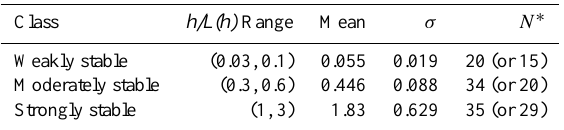
Table 1. Description of the classification of stability based on the parameter h/L(h) at tree top, where h is the tree canopy height and L(h) is the Obukhov length at tree top.